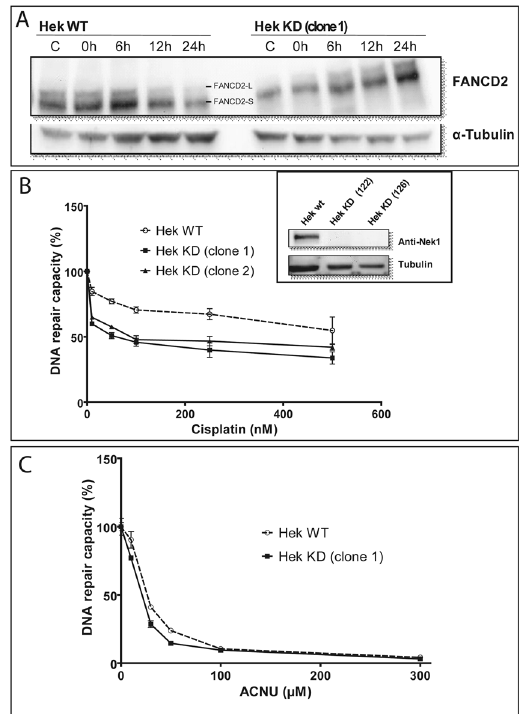
Figure 4. NEK1 is involved in DNA damage signaling and repair of cisplatin-, but not ACNU-induced lesions. ( A ) Representative Western blot showing FANCD2 ubiquitination after treatment with 15 µ M of cisplatin for 2 h and different times of recovery. HCR assay with a luciferase plasmid treated with increasing doses of ( B ) cisplatin and ( C ) ACNU. Insert: NEK1 expression levels of wild type (HEK WT) and two NEK1-knockdown clones. The figures are representative of at least two independent experiments. In the graphs, the results are presented as the means ± SE from three independent experiments performed in